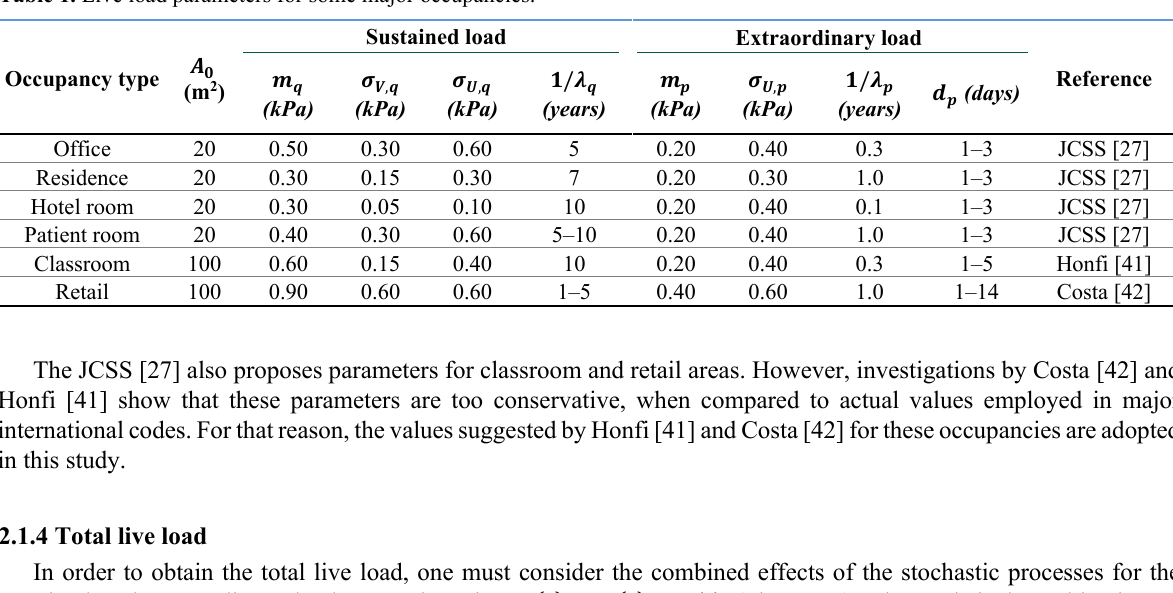
Table 1. Live load parameters for some major